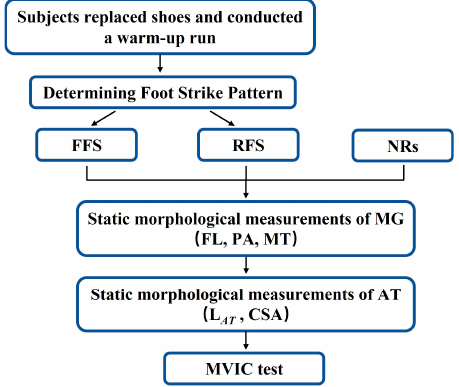
Figure 2. Diagram of the experimental flow chart.